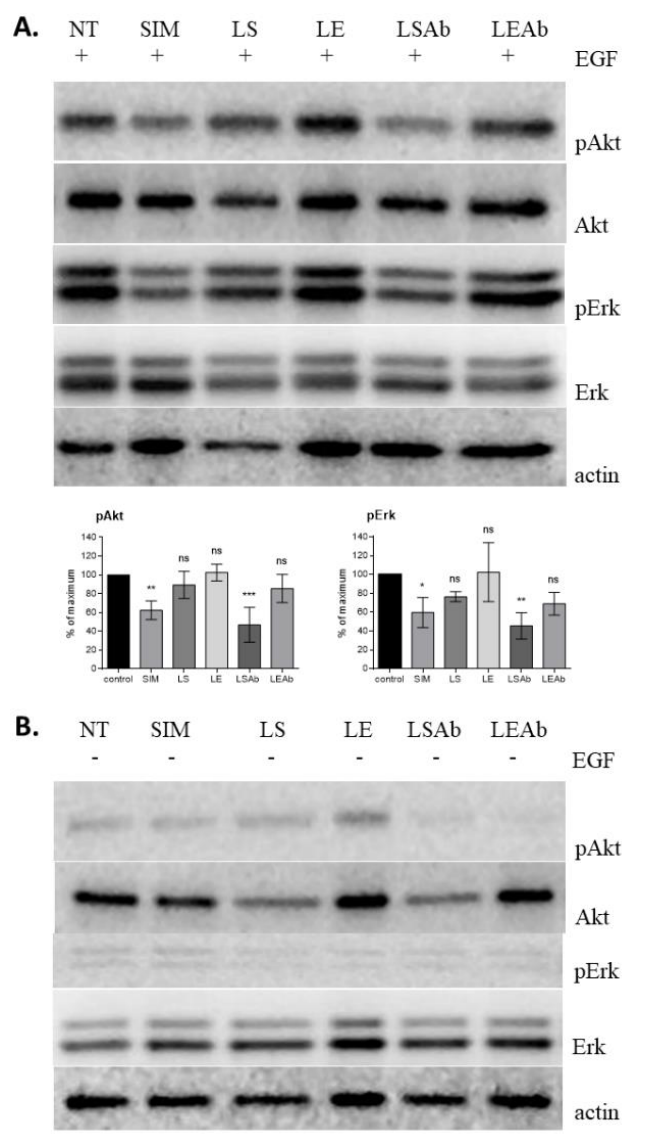
Figure 8. Levels of activation of Erk and Akt kinases in SKBR3 cells treated with simvastatin liposomes and simvastatin immunoliposomes. Cells were treated with liposomal forms of simvastatin for 24 h, and subsequently stimulated with EGF (100 ng/mL) for 15 min ( A ) or not stimulated ( B ), and then cell lysates were prepared and analysed by Western blot. NT: untreated cells; SIM: pure simvastatin; LS: non-targeted simvastatin liposomes; LE: non-targeted empty liposomes; LSAb: simvastatin immunoliposomes; LEAb: empty immunoliposomes. Statistical significance was determined on the basis of three independent experiments, by one way ANOVA with a post hoc Dunnett’s test, and differences were considered statistically significant at p < 0.05 (*), p < 0.005 (**), p < 0.0005 (***), ns: not significant ( p > 0.05).